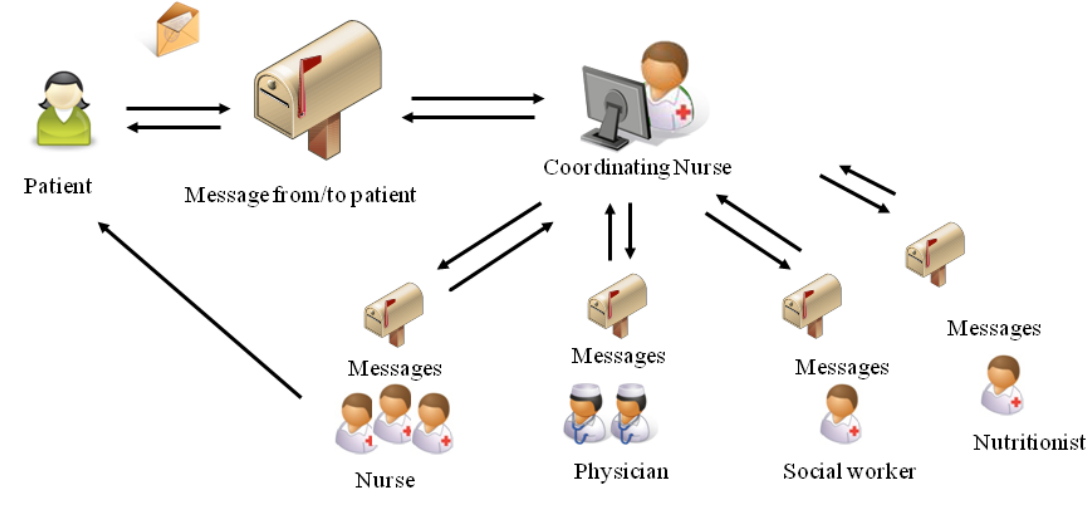
Figure 1. IPPC message flow between patients and health care